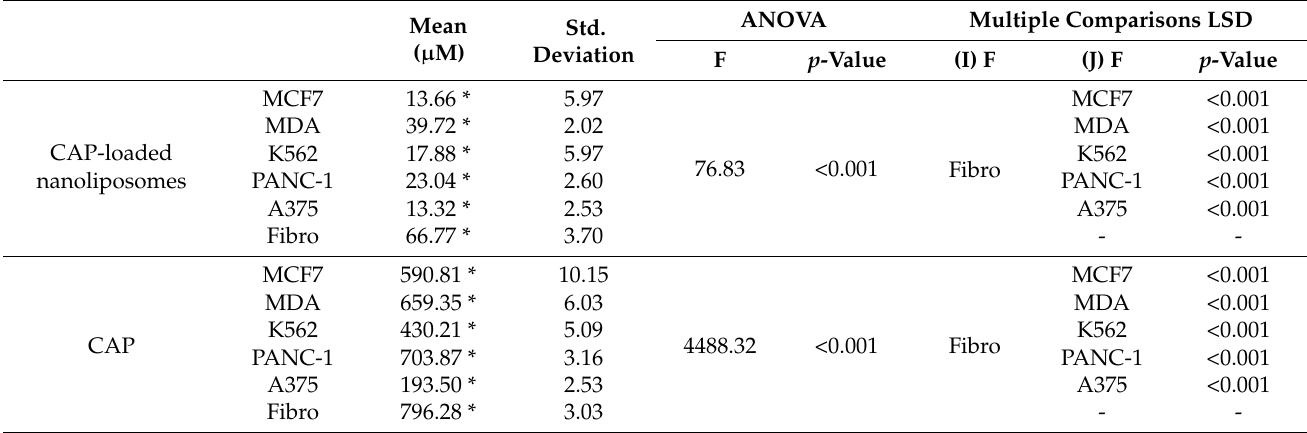
Table 3. Comparison of cytotoxic activities of CAP and CAPloaded nanoliposomes against human cancer cells and human normal fibroblasts